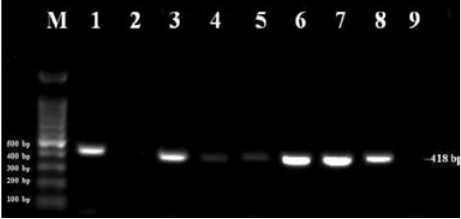
Fig. 2. Agarose gel electrophoresis of Mycoplasma ovipneumoniae specific PCR